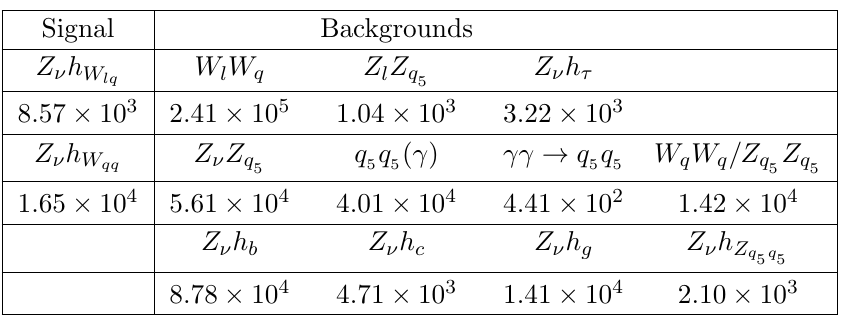
Table 5 . Numbers of the signal and its main background events after preselection, for measuring (cid:27) ( Z (cid:23) h W ) and (cid:27) ( Z (cid:23) h W ). We use Pythia8 to simulate the impact of initial state radiation and qq lq beamstrahlung for the q q production. The (cid:28) decays of the W=Z bosons are also incorporated in 5 5